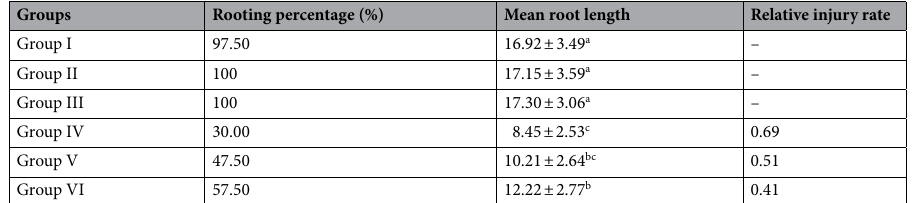
Table 2. Effect of pendimethalin and curcumin on rooting percentage and root length. Group I: tap water (control), Group II: 5 mg/L curcumin, Group III: 10 mg/L curcumin, Group IV: 12 mg/L pendimethalin, Group V: 12 mg/L pendimethalin + 5 mg/L curcumin, Group VI: 12 mg/L pendimethalin + 10 mg/L curcumin. Data are shown as mean ± standard deviation (SD). The averages shown with different letters in the same column are statistically significant ( P < 0.05).